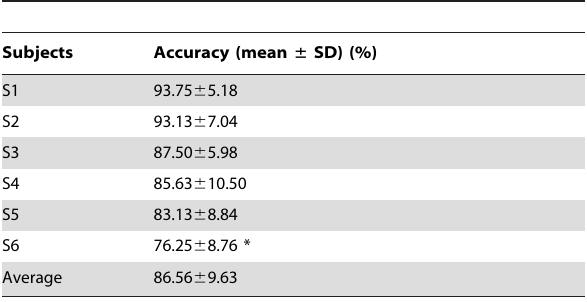
Table 1. Offline detection accuracies on fixed time window length (4 s).